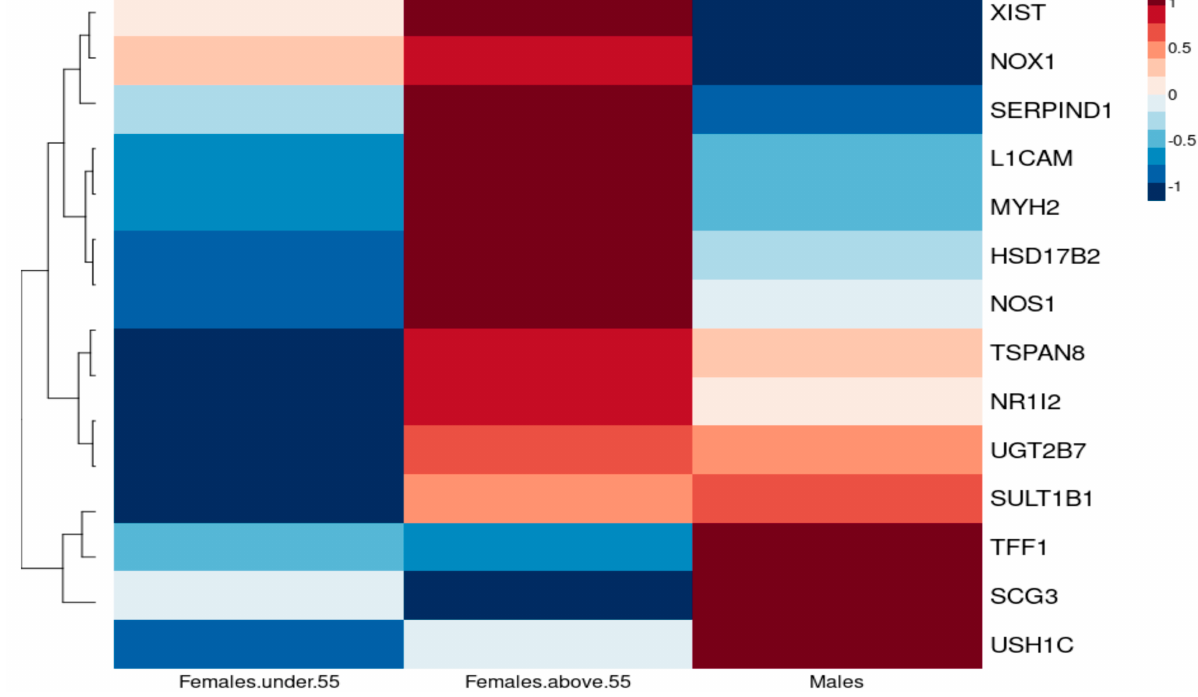
Figure 7. Heatmap reflecting the differential median expression across all the samples, illustrating the individual genes that are differentially expressed between premenopausal (under 55 years of age), postmenopausal females (over 55 years of age) and males.